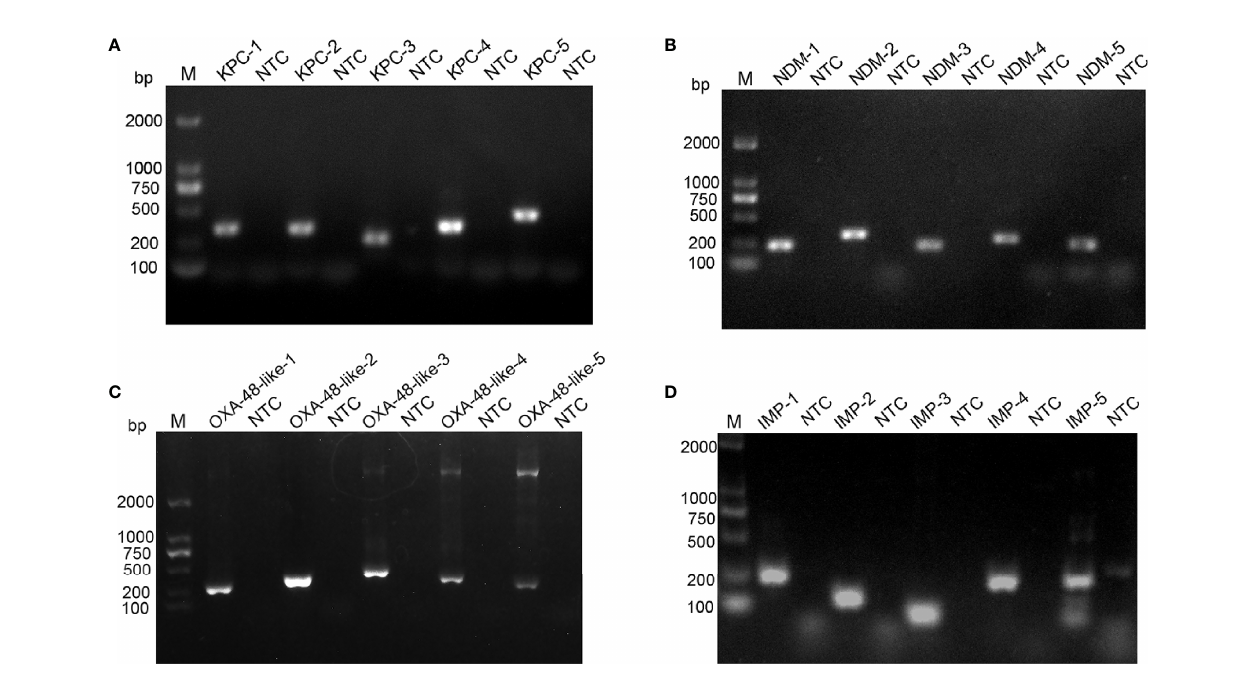
FIGURE 1 | Screening of optimal primer pairs using RPA ampli fi cation reactions. Agarose gel images show the ampli fi cation results of fi ve primer pairs designed for bla KPC (A) , bla NDM (B) , bla OXA-48-like (C) and bla IMP (D) genes. The name of each primer pair is above each lane: Lane M is DNA ladder. NTC lanes are template-free controls for the respective primer pairs. Band sizes of the DNA ladders are shown on the